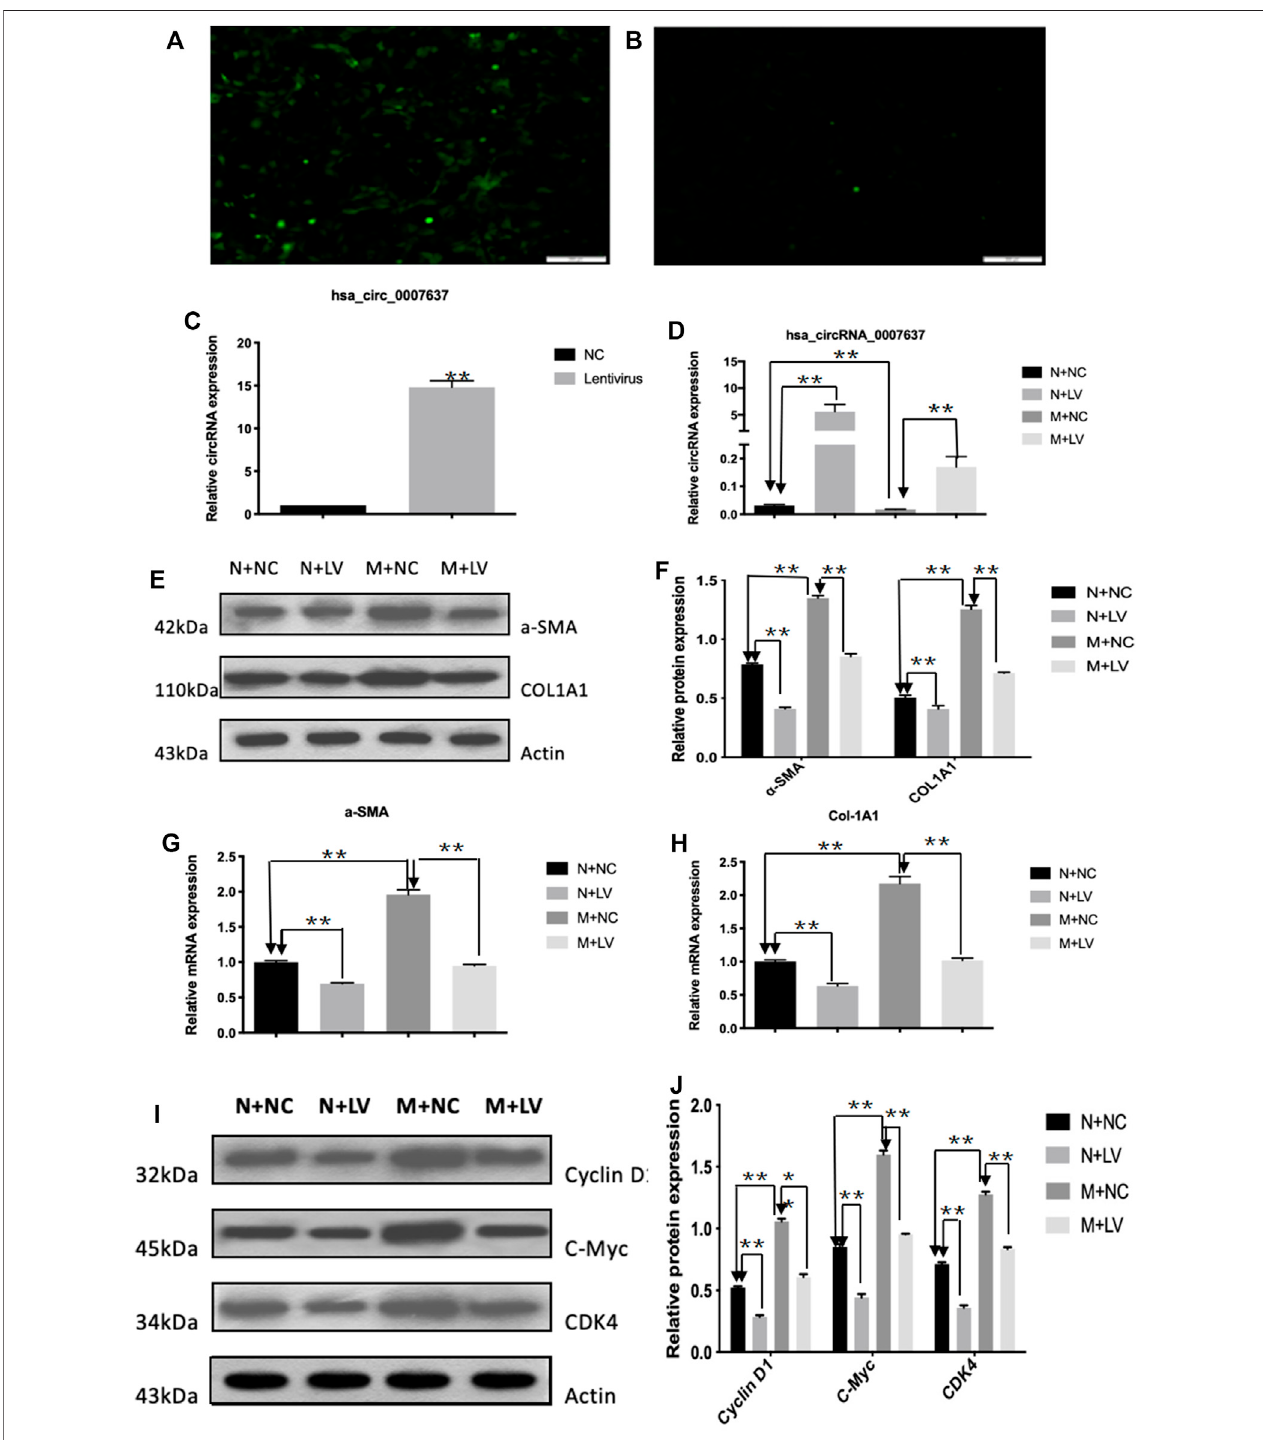
FIGURE4| CircCREBBPsuppressesactivationandproliferationofLX-2cellsinvitro. Theup-regulated theexpressionlevelofhsa_circ_0007637inLX-2cellsand theef fi ciencyofoverexpressionhsa_circ_0007637 (A – C) .Theup-regulatedexpressionofcircCREBBPsubsequentlydecreasedthemRNAandproteinlevelsof α -SMA and Col1A1 (D – H) . CircCREBBP could arrest cycle and inhibit cell proliferation (I,J) .